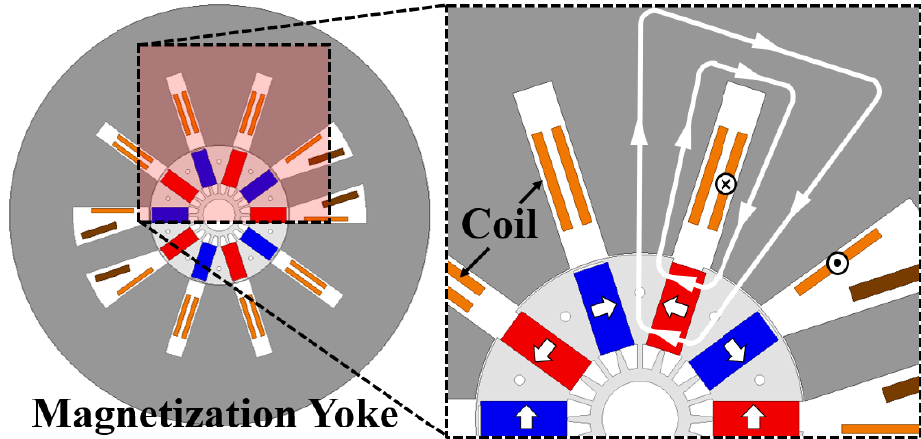
Figure 4. A 10 pole spoke-type rotor and three-time magnetizer.